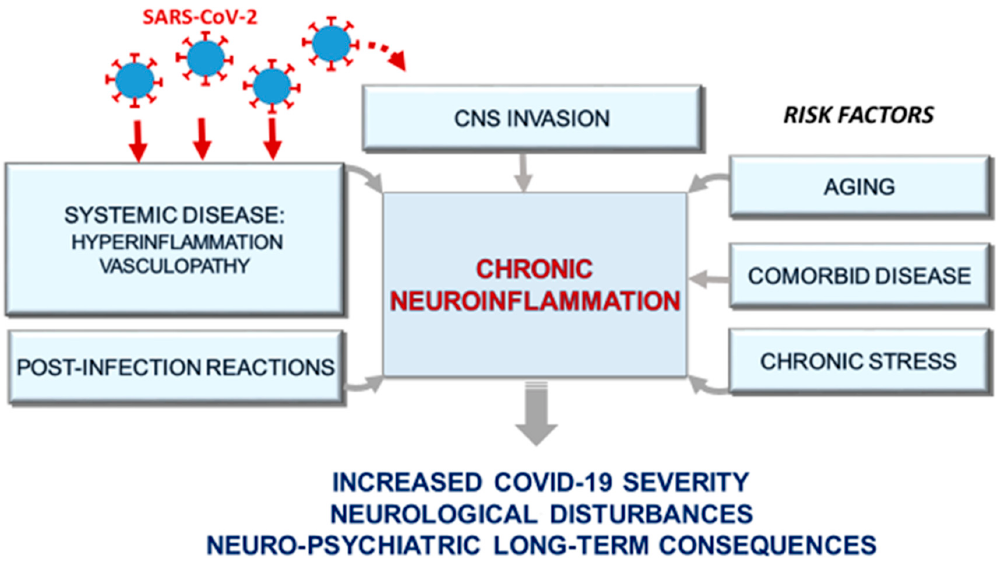
Figure 2. Potential impact of chronic neuroinflammation on COVID-19 severity: a detailed explanation of the drawing is reported in the text. CNS: Central Nervous